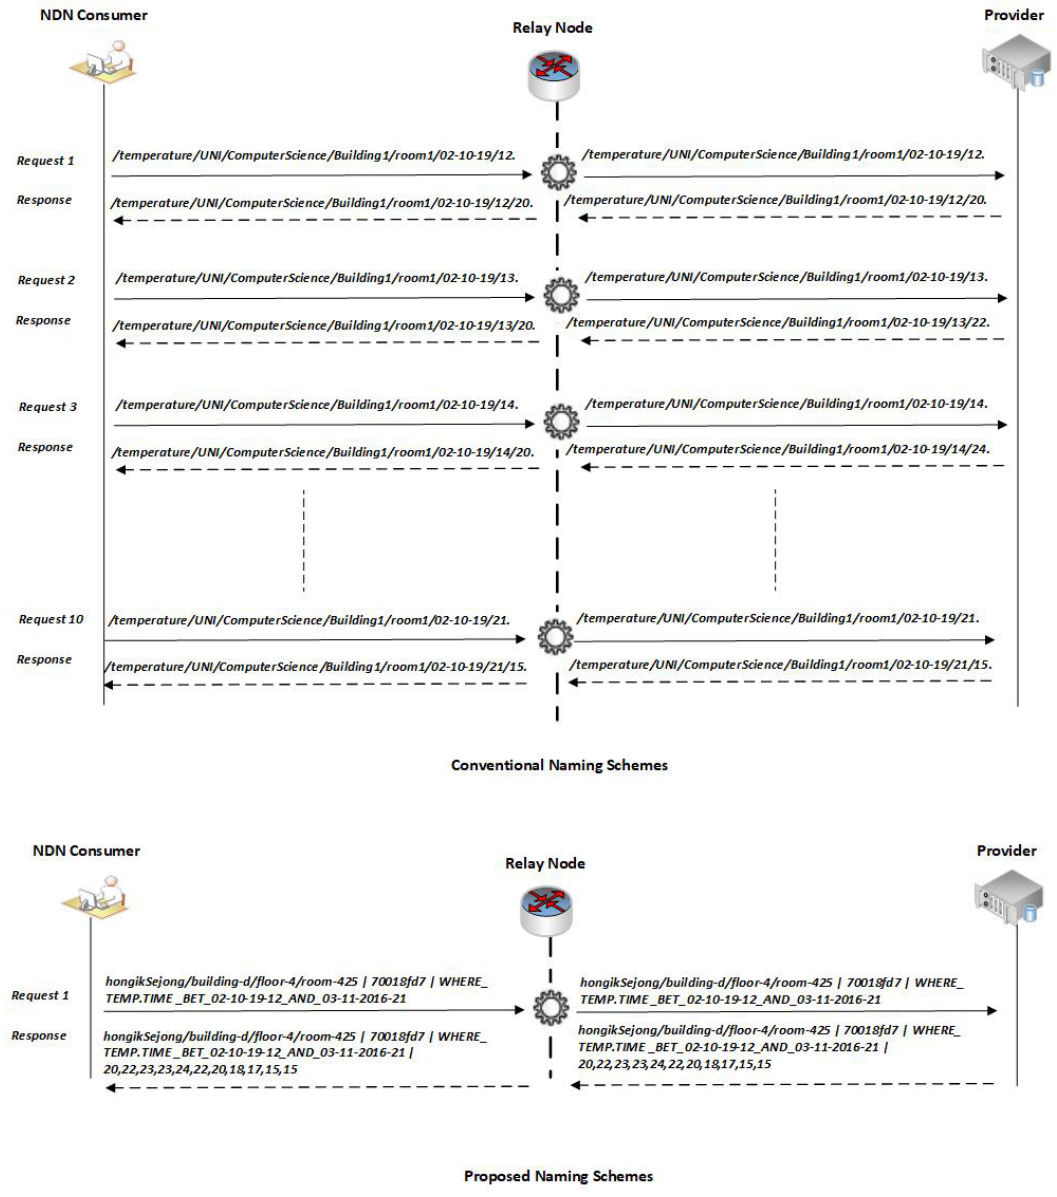
Figure 8. A comparison of NINQ with conventional naming